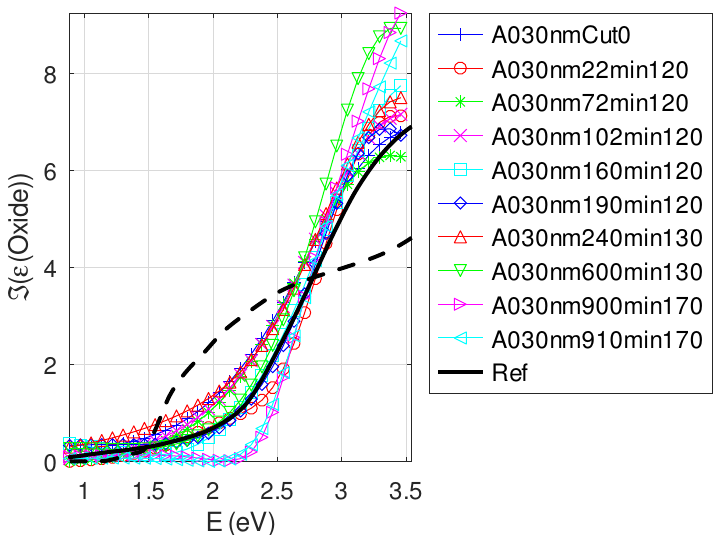
Figure A10. Imaginary part of the relative permittivity of oxide as a function of the photon energy: bulk Cu 2 O (black solid line), bulk CuO (black dashed line) and best calculated (color) for each = 30 oxidized sample (initial thickness h 0 Cu